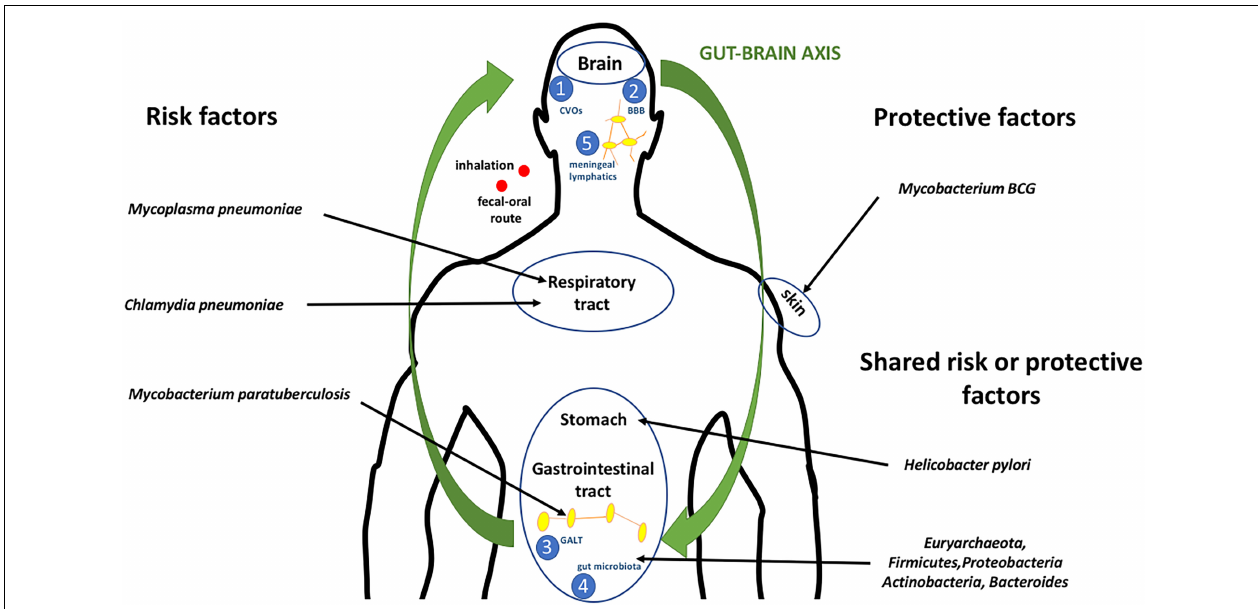
FIGURE 1 | Microbe–host interactions in MS. Bacteria gain access to the body by penetrating the mucous membranes of the respiratory and/or gastrointestinal tracts, or by direct inoculation. Microbial antigens can cross-activate peripheral T cells through different mechanisms, such as molecular mimicry, bystander activation, or epitope spreading. Naïve T cells recognize myelin and rearranged TCRs, and certain myelin-reactive CD4+ T cells can differentiate into Th1 and Th17 cells, then gain access to the CNS, where they are reactivated by APCs and have harmful effect on the CNS parenchyma. Furthermore, intestinal dysbiosis causes an imbalance between beneficial and pathogenic enteric bacteria, contributing to immune dysregulation in the periphery and subsequently influencing CNS immune tolerance. Bacteria may communicate with the brain through various routes, including: (cid:172) through circumventricular organs characterized into sensory and secretory organs, comprising the subfornical organ, vascular organ of the lamina terminalis, area postrema, median eminence, neurohypophysis, sub-commissural organ, choroid plexus, and pineal gland (Weiss and Schaible, 2015); (cid:173) through the BBB or the blood–cerebrospinal fluid barrier (Ganong, 2000); (cid:174) through the GALT, which consists of Peyer’s patches, intraepithelial lymphocytes, and lamina propria lymphocytes (Doran et al., 2013); (cid:175) through gut microbiota by a bi-directional communication system (gut–brain axis), including the autonomic nervous system, the enteric nervous system, the vagus nerve, and the hypothalamic pituitary adrenal axis (Wucherpfennig, 2001); and (cid:176) through meningeal lymphatics capable of draining CNS macromolecules into the cervical lymph nodes. Inflammation is known to induce expansion of the local lymphatic vasculature in peripheral tissues and, hence, it is likely that bacterial exposure autoimmune cell activation will occur (Cosorich et al.,